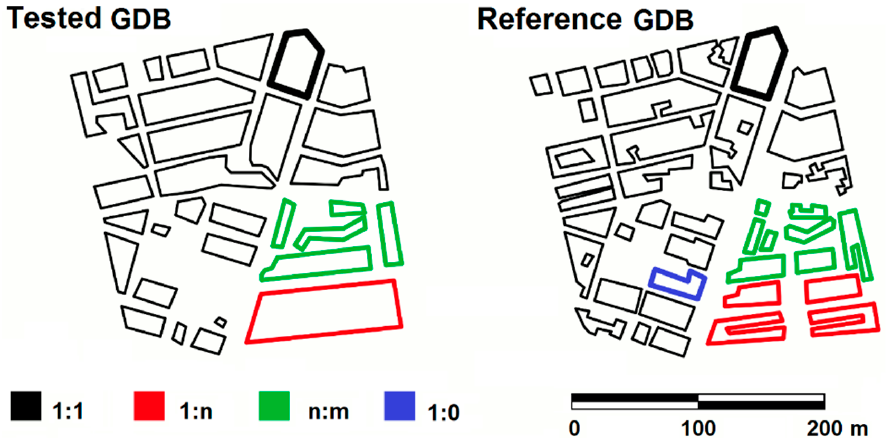
Figure 1. Some examples of correspondences between polygons. Example of 1:1 correspondence (black), example of 1:n correspondence (red), examples of n:m correspondences (green) and example of 1:0 correspondence (blue). Source: [1].